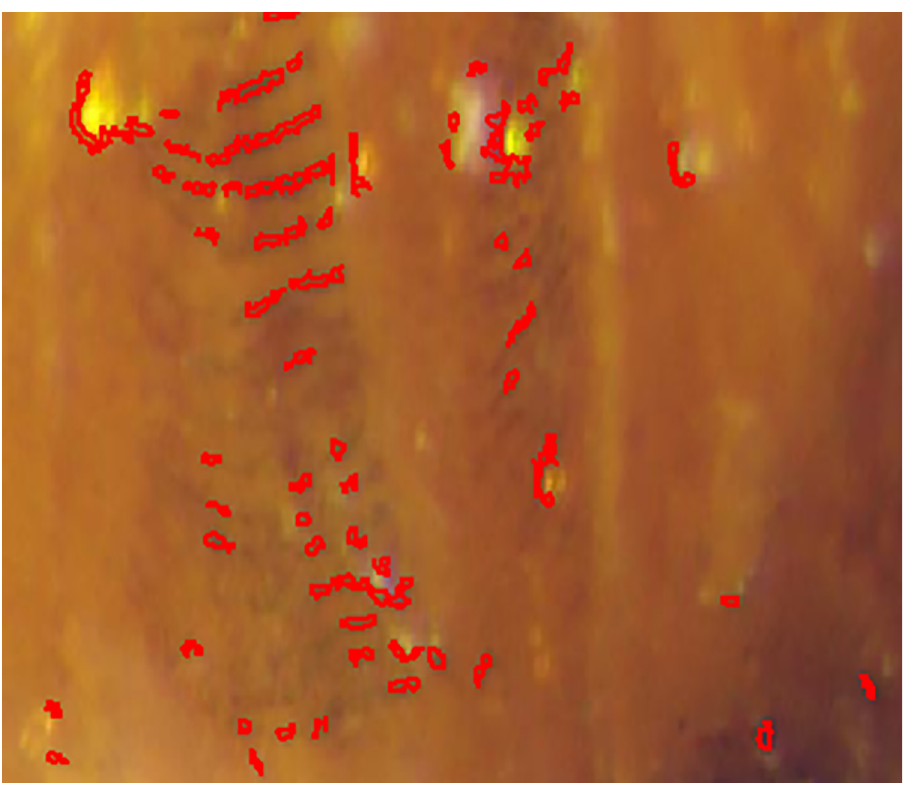
Fig 3. Characteristics of male and female pupae in area 17.